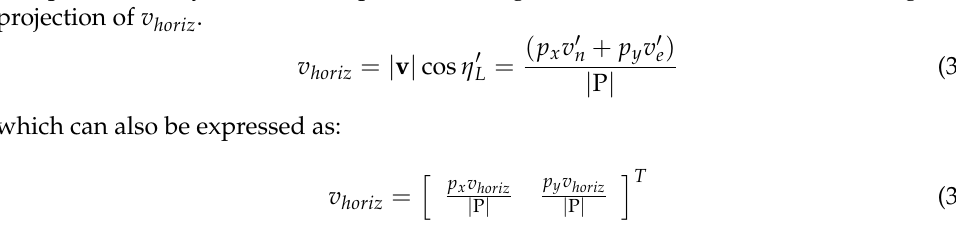
Figure 11. Follower heading control command tracking effect.